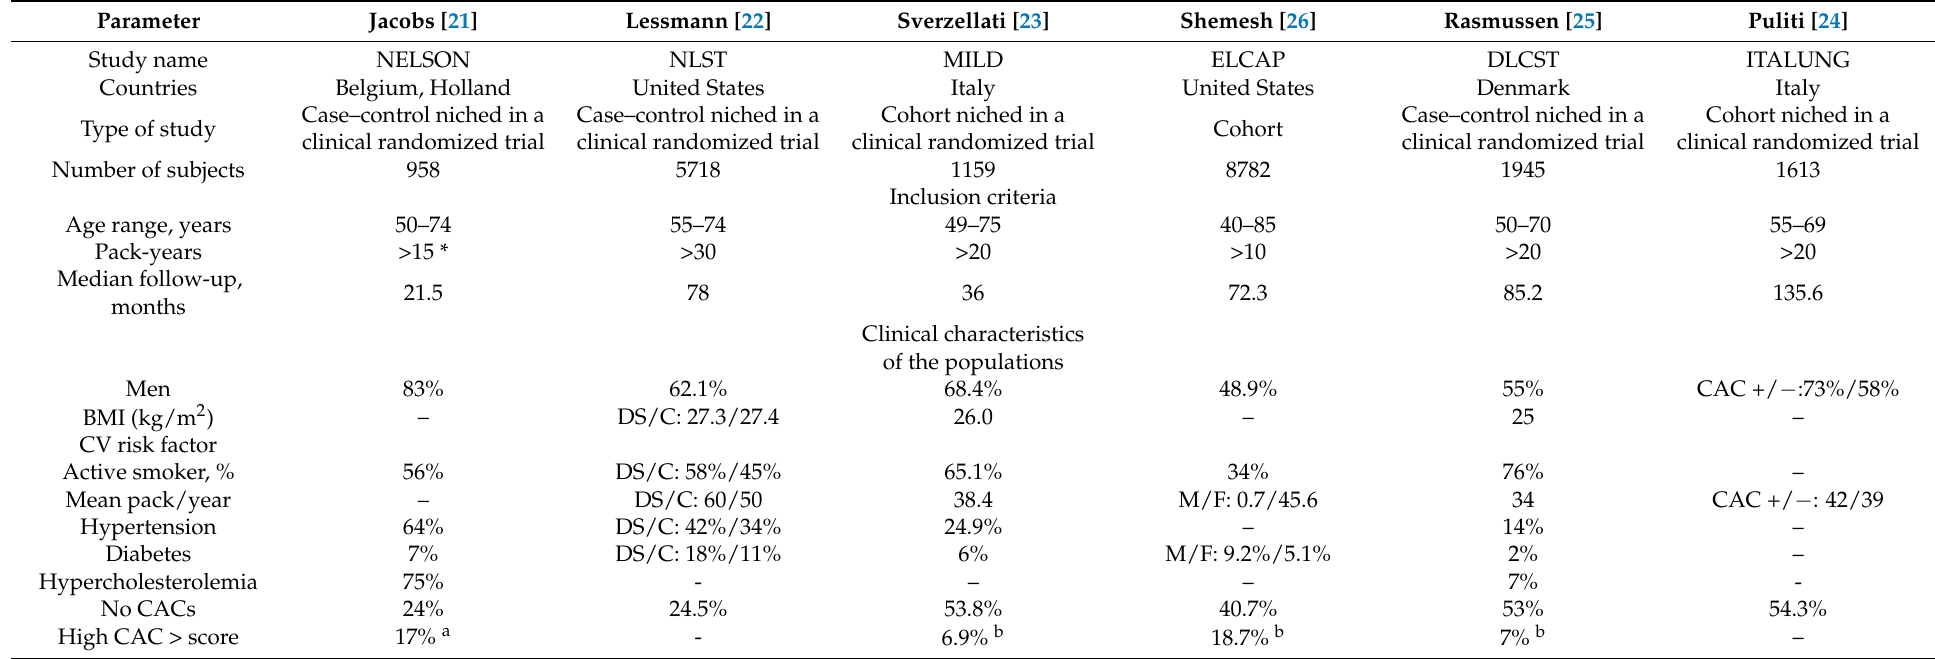
Table 1. Sociodemographic and clinical characteristics of the populations in studies retained for the